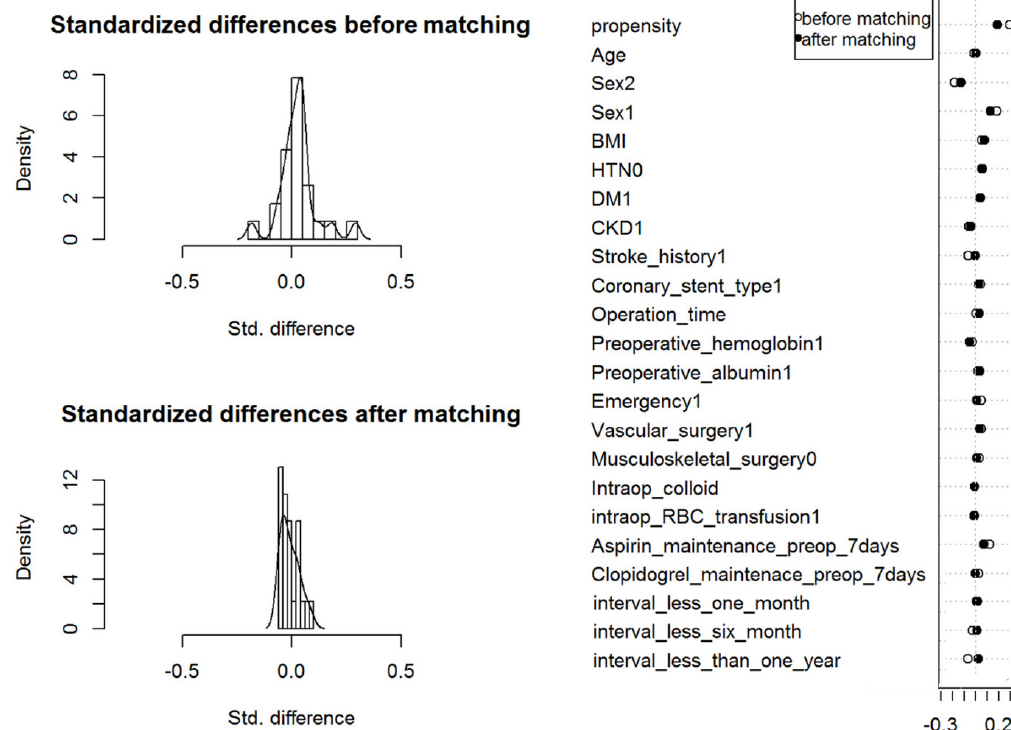
Figure 2. Histogram and covariate balance plot of distribution of propensity scores between patients with total intravenous anesthesia and volatile anesthetics. BMI = body-mass index; HTN = hypertension; DM = diabetes mellitus; CKD = chronic kidney disease; intraop = intraoperative; RBC = red blood cell; ASA = aspirin; interval = the interval between coronary stent insertion and surgery.